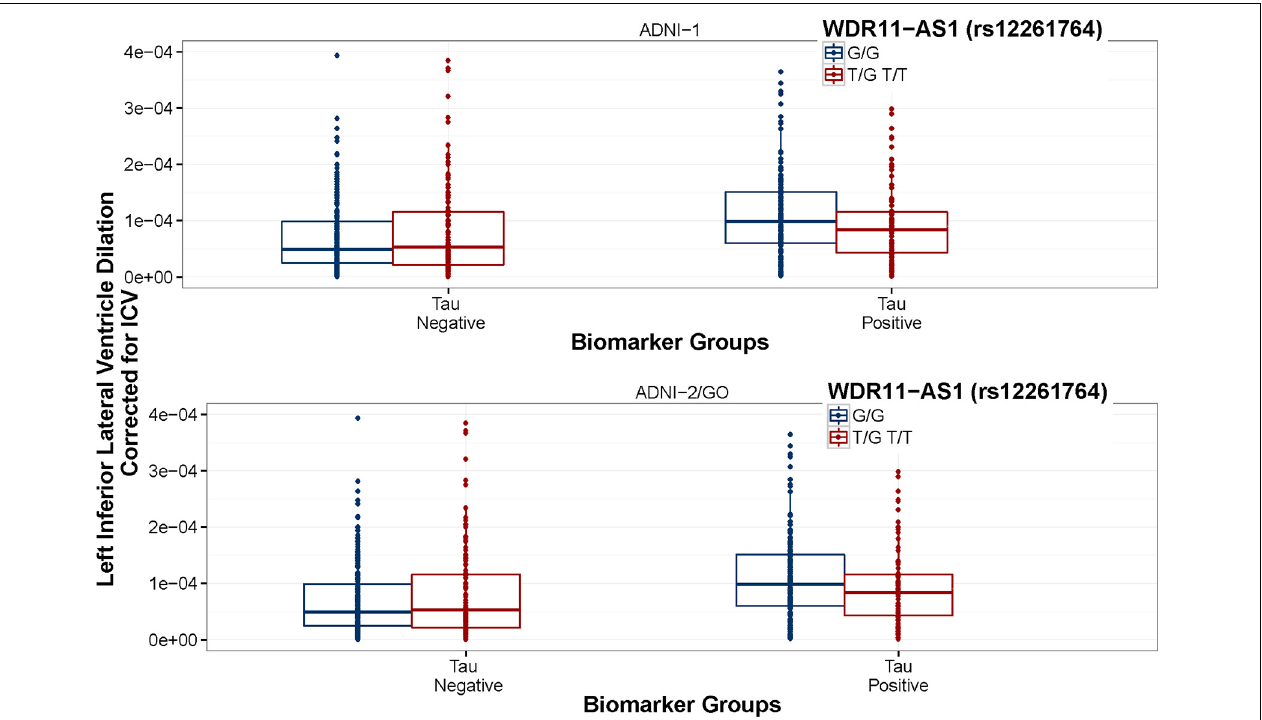
FIGURE 5 | WDR11-AS1 (rs12261764) interaction is consistent between datasets. ADNI-1 data are presented in the top panel and ADNI-2/GO data are presented in the bottom panel. Biomarker groups are presented on the x-axis and annual change in the left inferior lateral ventricle is presented on the y-axis. Boxplots are grouped by rs12261764. G is the minor allele. The